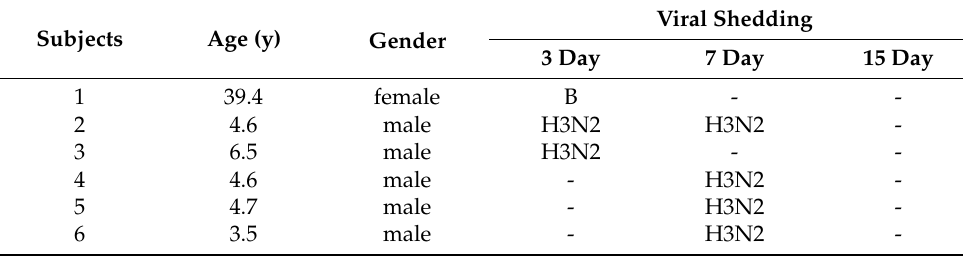
Table 6. Details of subjects shed